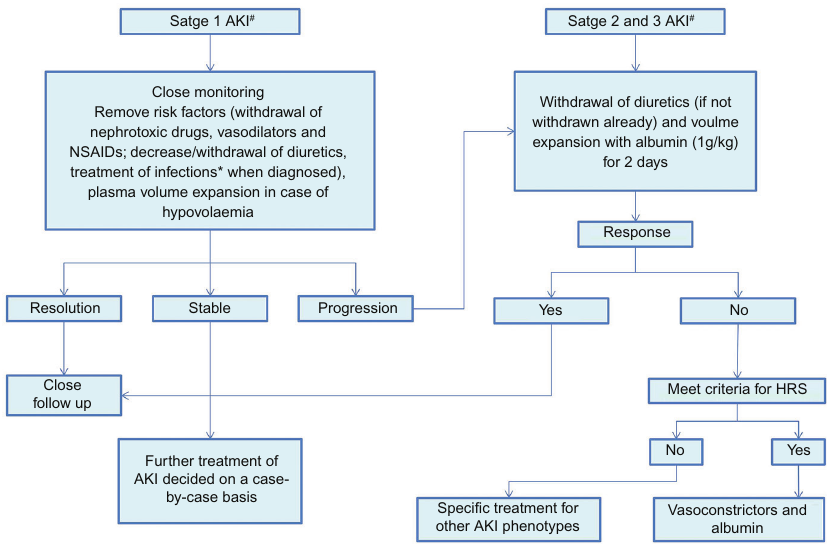
Figure 2. Proposed algorithm for the management of acute kidney injury in patients with cirrhosis and ascites. *Treatment of spontaneous bacterial peritonitis should include albumin infusion according to current guidelines. # Initial AKI stage is de fi ned as AKI stage at the time of fi rst ful fi lment of the AKI criteria. AKI, acute kidney injury; HRS, hepatorenal syndrome; NSAIDs, non-steroidal anti-in fl ammatory drugs. Reproduced with permission from Angeli et al.